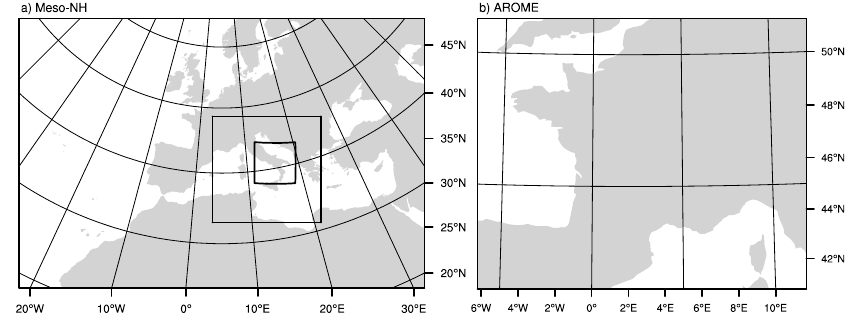
Fig. 1. Domains of (a) the outer Meso-NH model and (b) AROME. In (a) the boxes show the location of the two inner